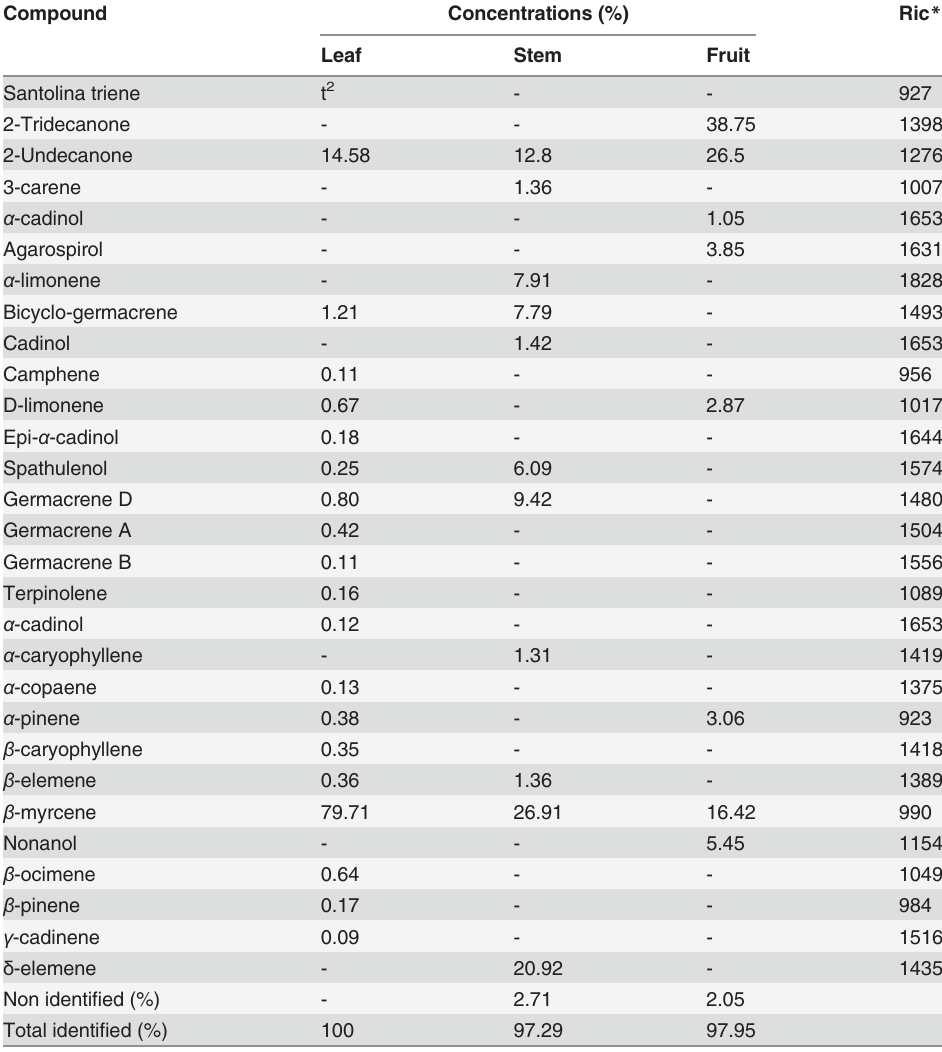
Table 1. Chemical composition, concentrations (%), and Kovats indices for Siparuna guianensis essential oil. Compound Concentrations (%)